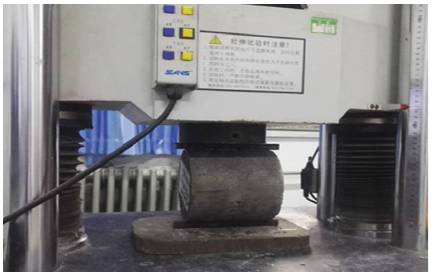
Figure 11: Splitting strength